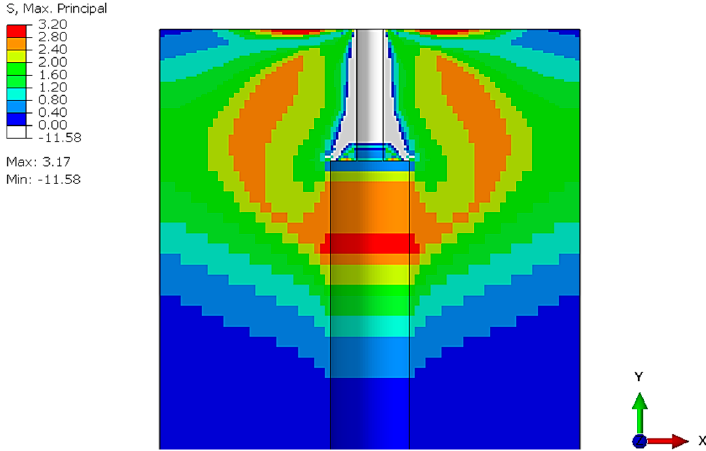
Figure 19. Map of maximum principal stresses for the POT-10 series.